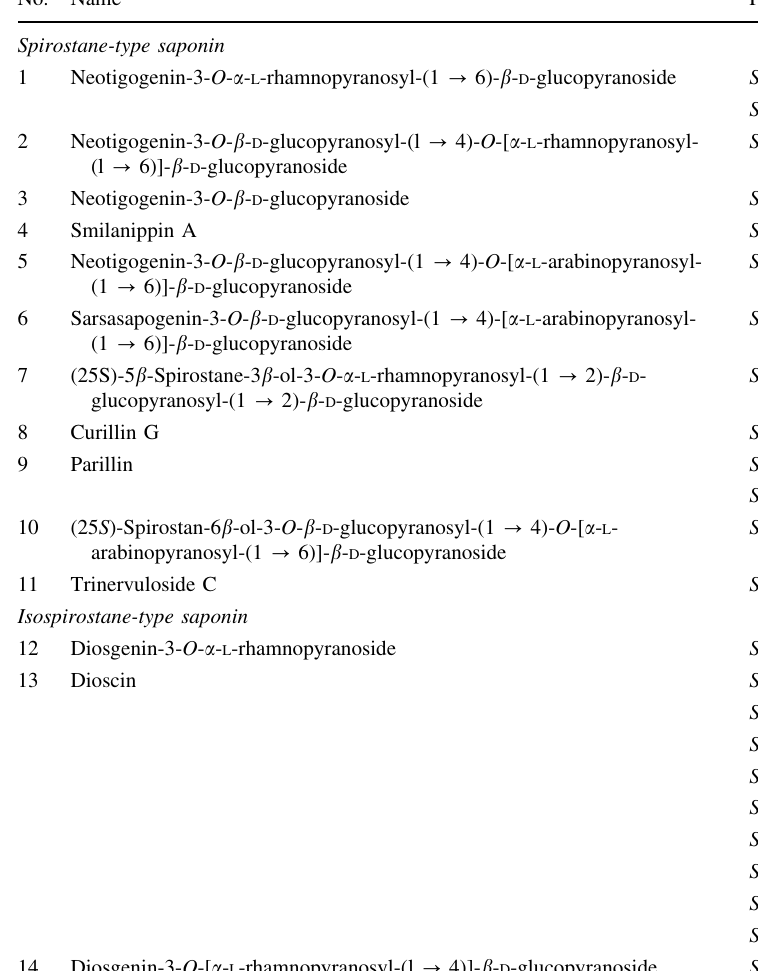
Table 1 Steroidal saponins from the Genus Smilax No.